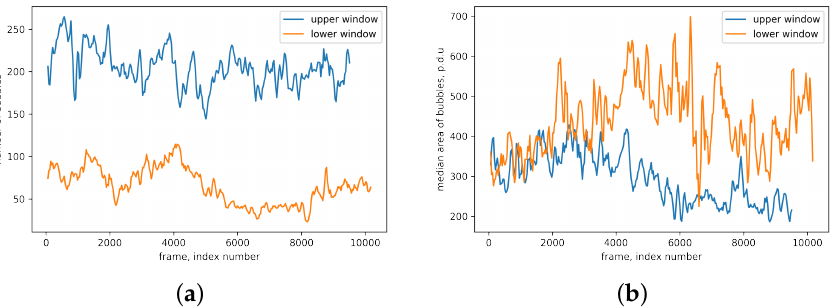
Figure 25. Number ( a ) and median area ( b ) of bubbles from upper window (blue) and lower window (orange) videos.